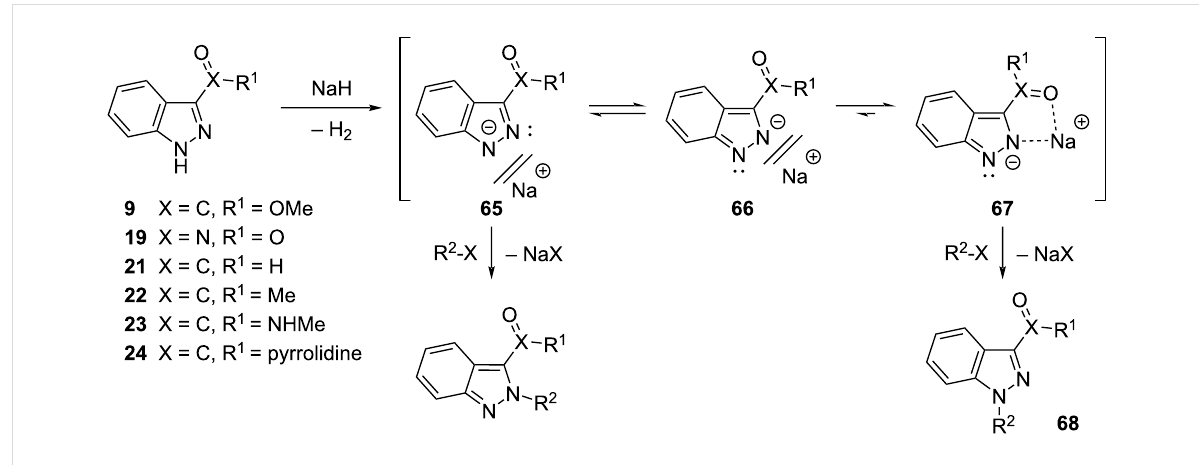
Scheme 3: Proposed mechanism for the regioselective N -1 alkylation of indazoles 9 , 19 , and 21 – 24 in the presence of NaH in THF (conditions A).